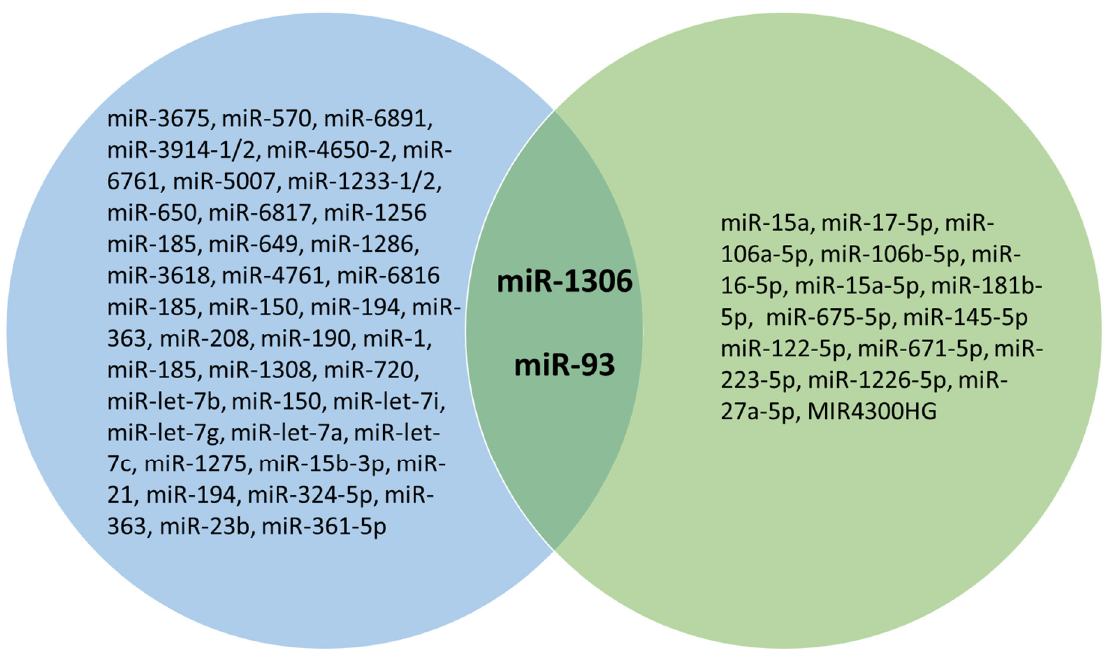
Figure 4. Venn diagram showing miRNAs dysregulated in 22q11.2DS (blue circle) and in adolescent idiopathic scoliosis (green circle). The two miRNAs dysregulated in both diseases are in bold.